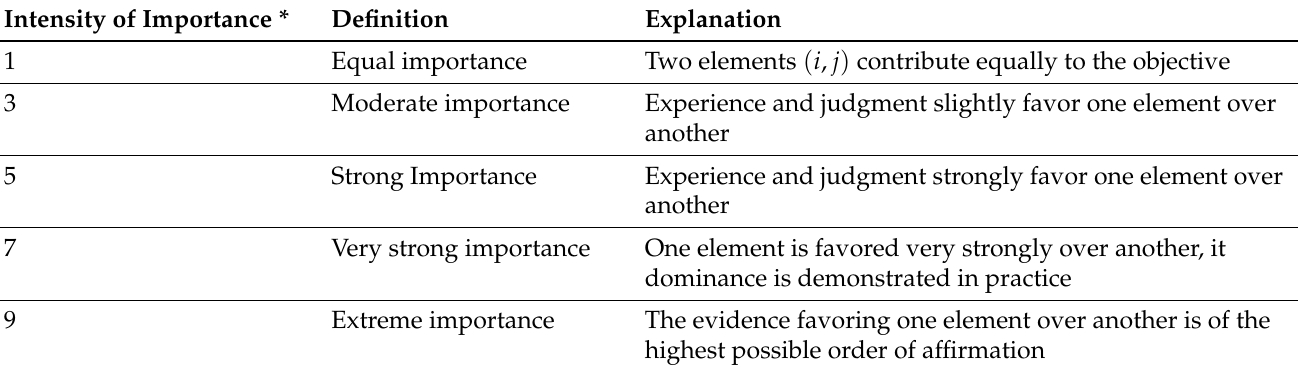
Table 2. Pairwise comparison scale [66].